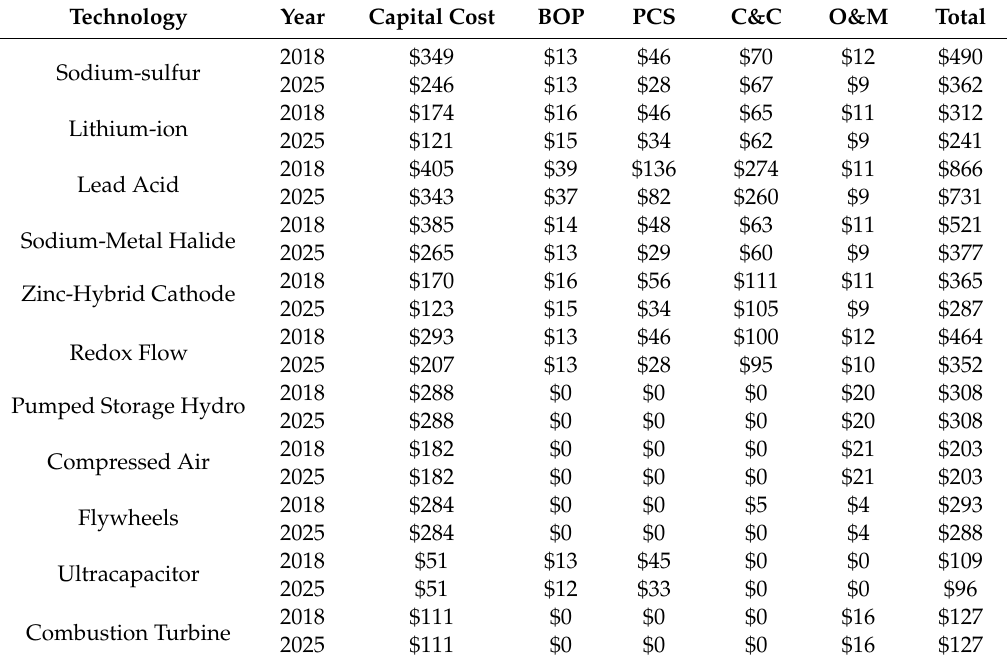
Table 37. Annualized costs for each technology, 2018 and 2025 ($ / kW).